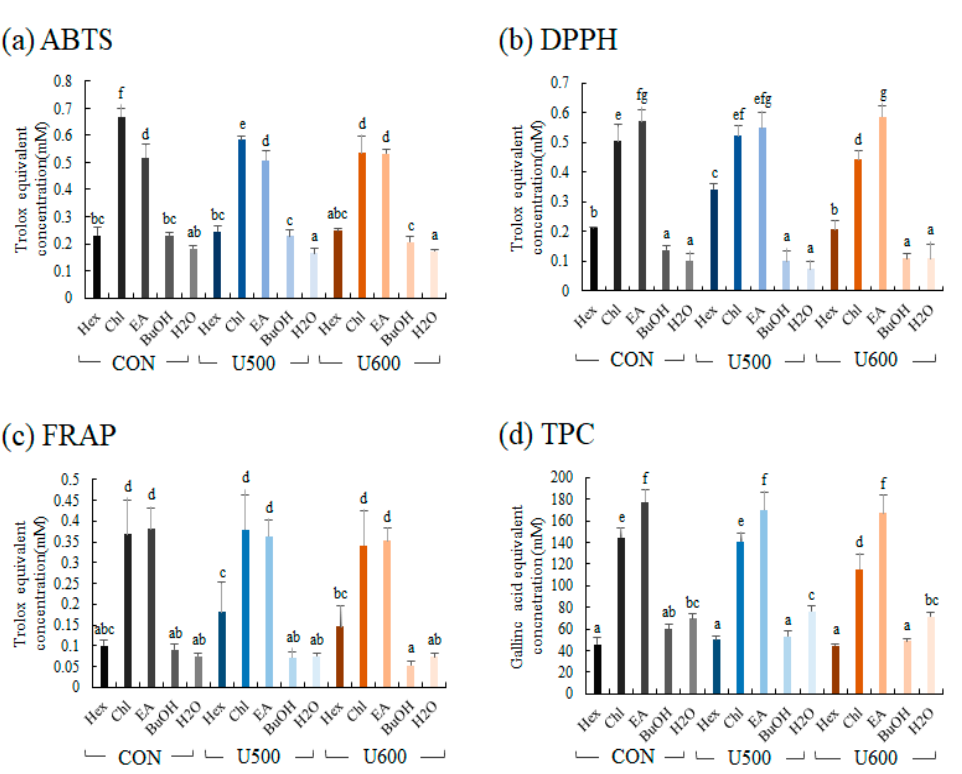
Figure 7. Antioxidant activity assay ( a ) ABTS; ( b ) FRAP; ( c ) DPPH; ( d ) total phenolic contents (TPC) of different solvent fractions. Values are expressed as the average of three biological replicates. The bar graph denoted by the same letter shows absence of statistical difference, according to Duncan’s multiple range test ( p < 0.05). (Hex, Hexane fraction; Chl, Chloroform fraction; EA, Ethyl acetate fraction; BuOH, Butanol fraction; H 2 O, Water fraction).